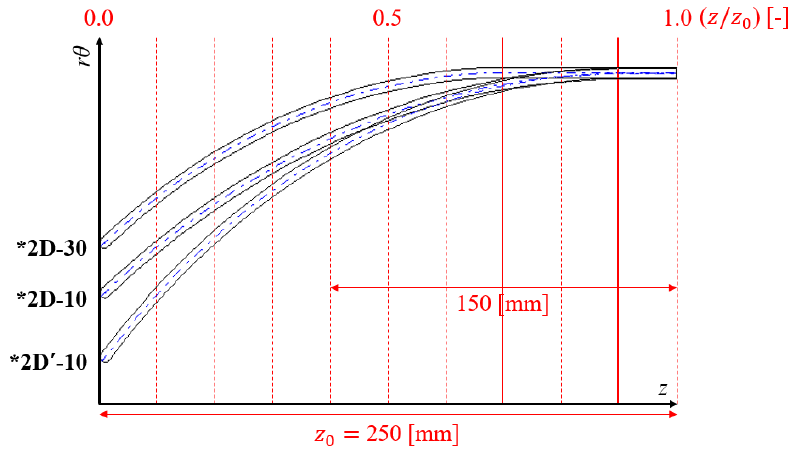
Figure 14. Further-designed guide vanes in blade-to-blade view: extended meridional length (*); weighted inlet vane angle (’).